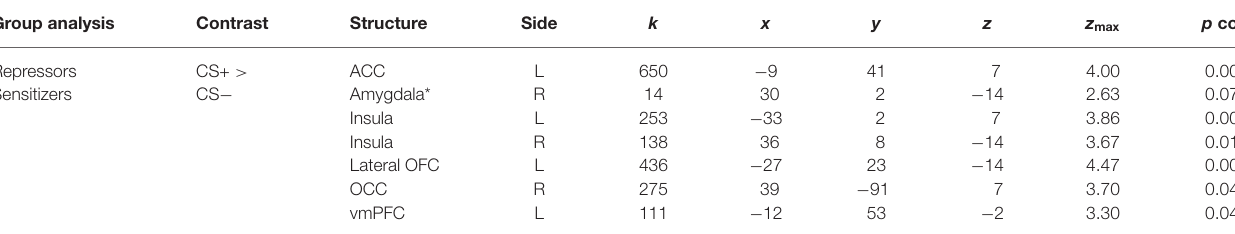
TABLE 1 | ROI-activations (CS+ > CS − ) for fear conditioning (whole phase) . Group analysis